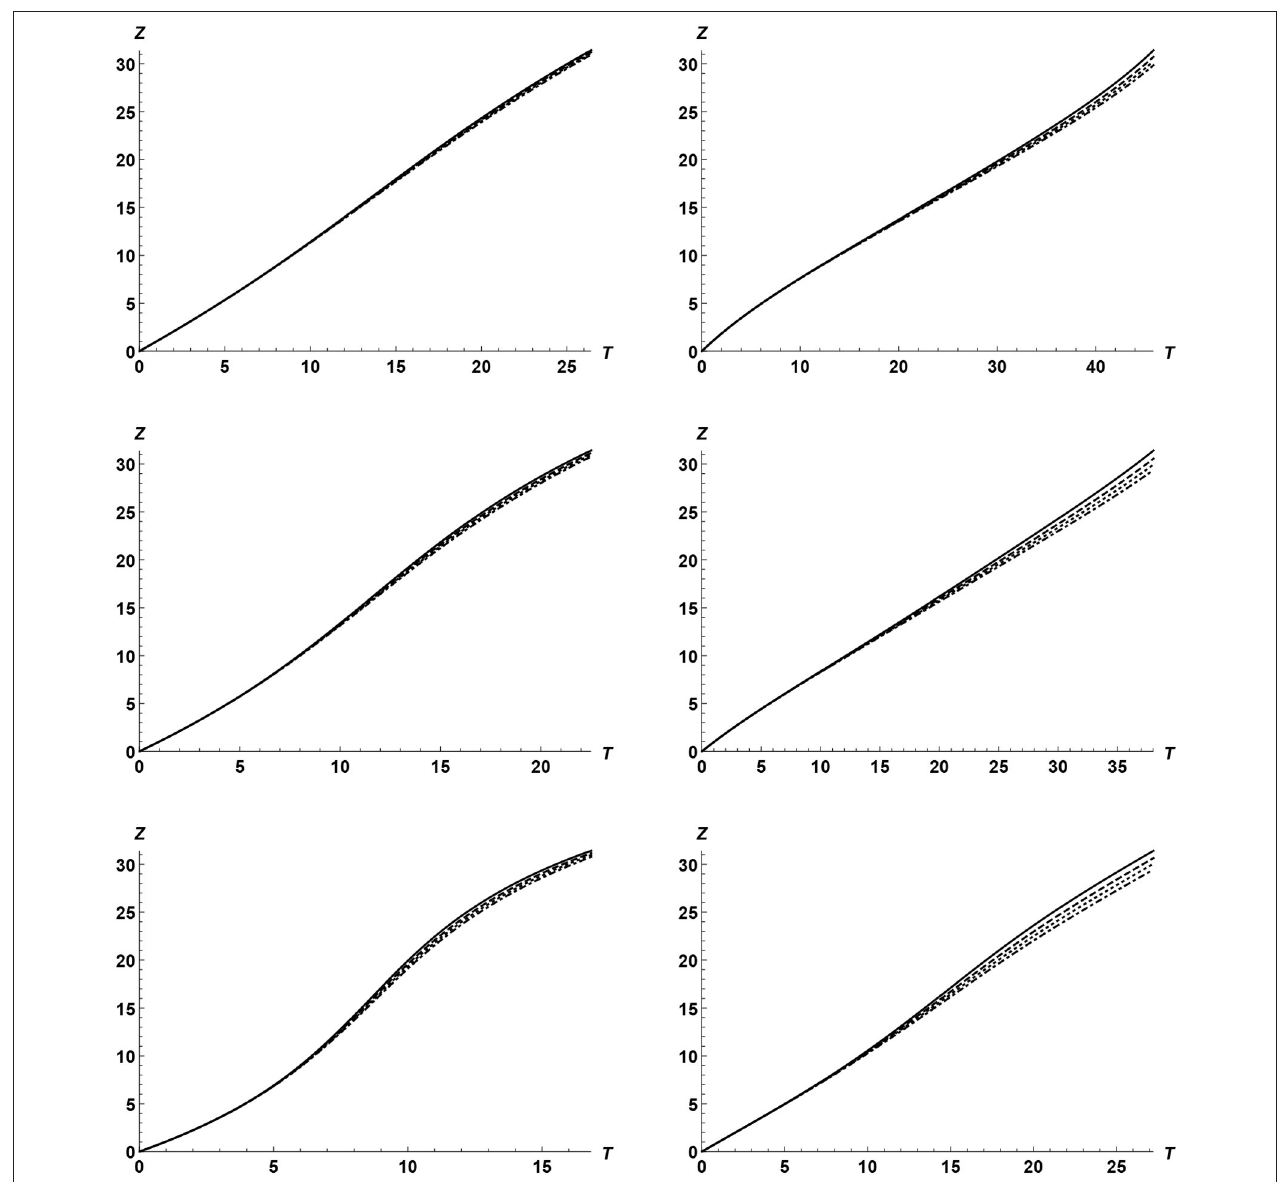
FIGURE 2 | Dependence of the wave front position on time. The calculations continued until the wave front reaches the other end of the magnetic tube. The left panels correspond to λ dotted, and dash-dotted curves correspond to N